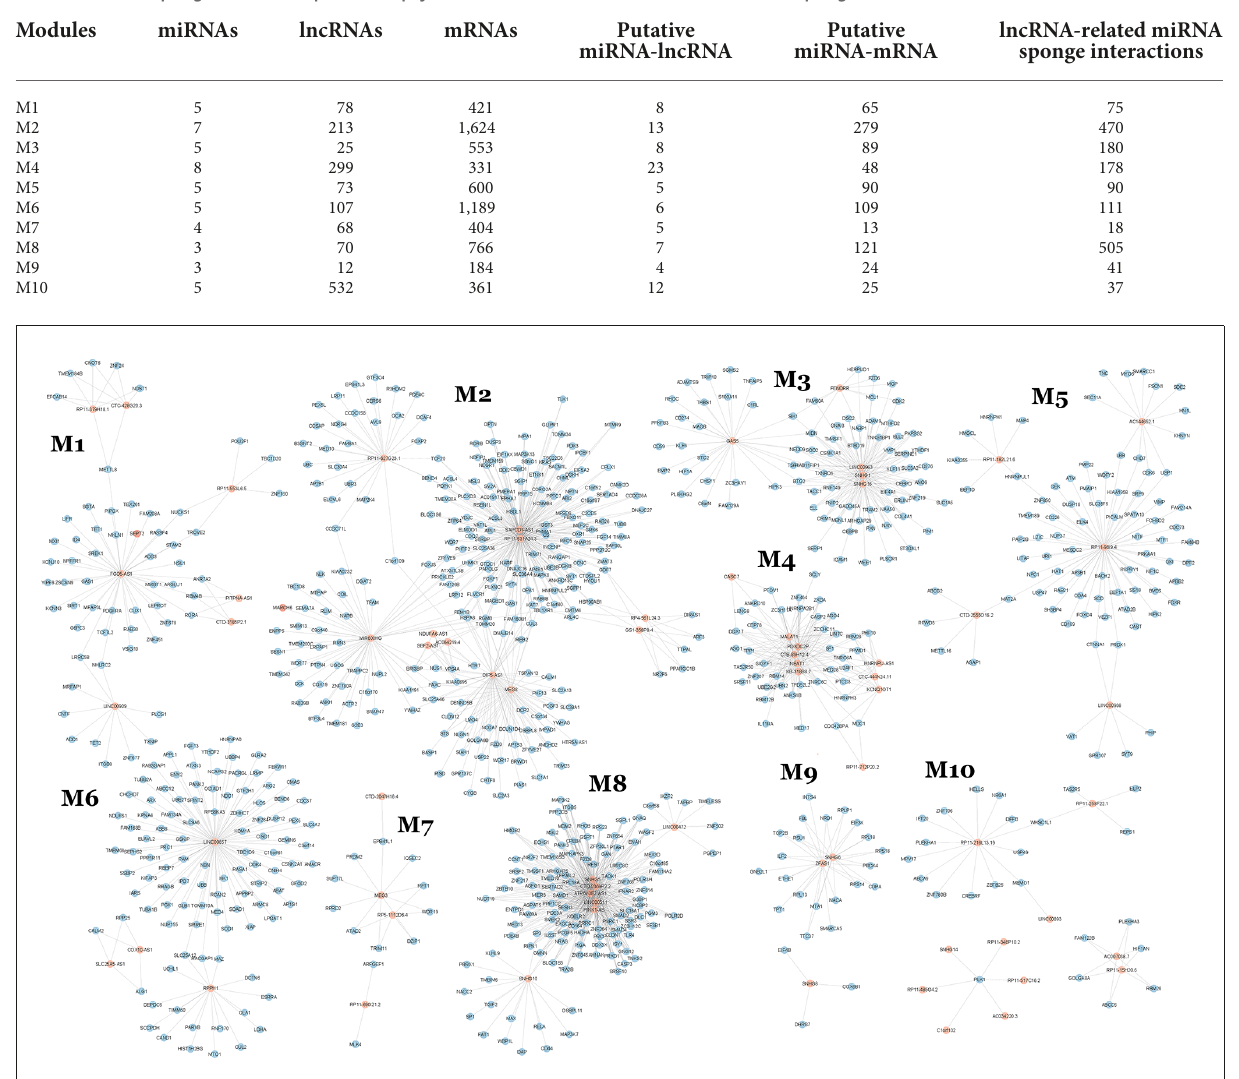
FIGURE2 lncRNA-related miRNA sponge modules of pan-neuropsychiatric disorders.